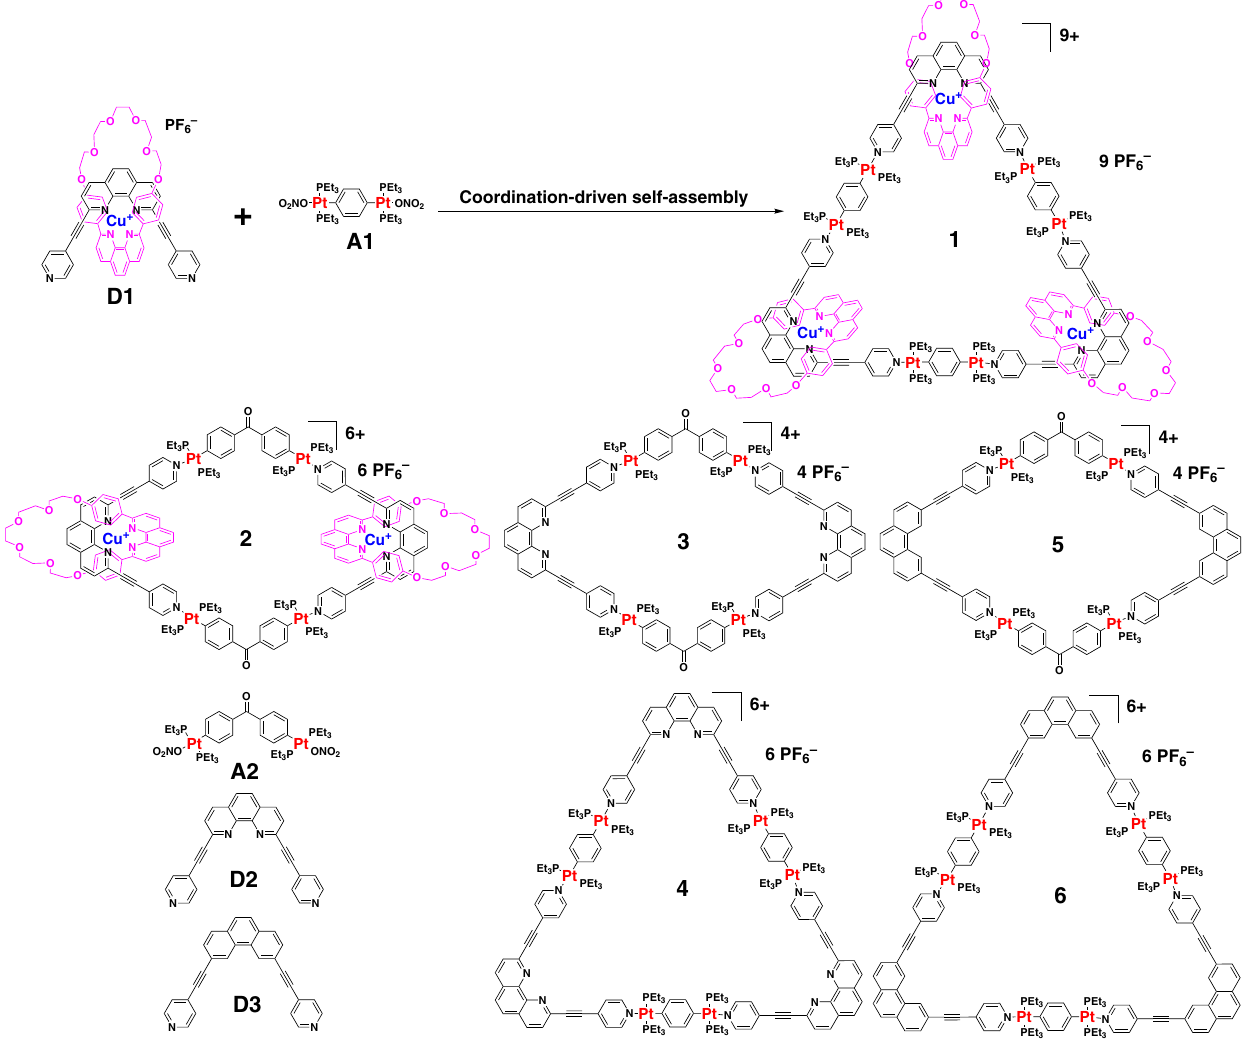
Fig. 2 Synthetic route and chemical structures of necklace 1 and related molecules used in this study. The self-assembly route of necklace 1 was demonstrated in the front